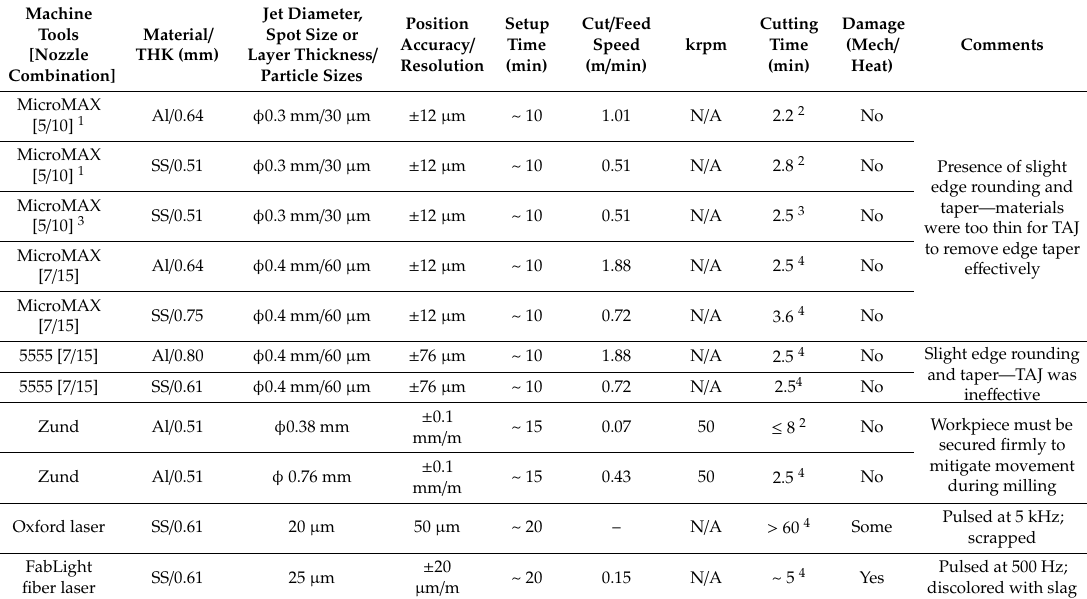
Table A1. Performance comparison—machining single-sheet flexures under the MicroCutting Project. Machine